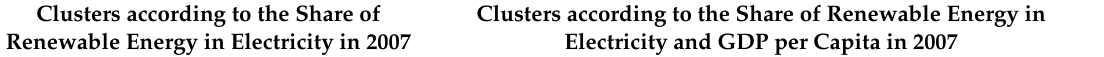
Table 3. Groups of countries in the EU-28 according to the share of renewable energy in electricity and GDP per capita in 2007.